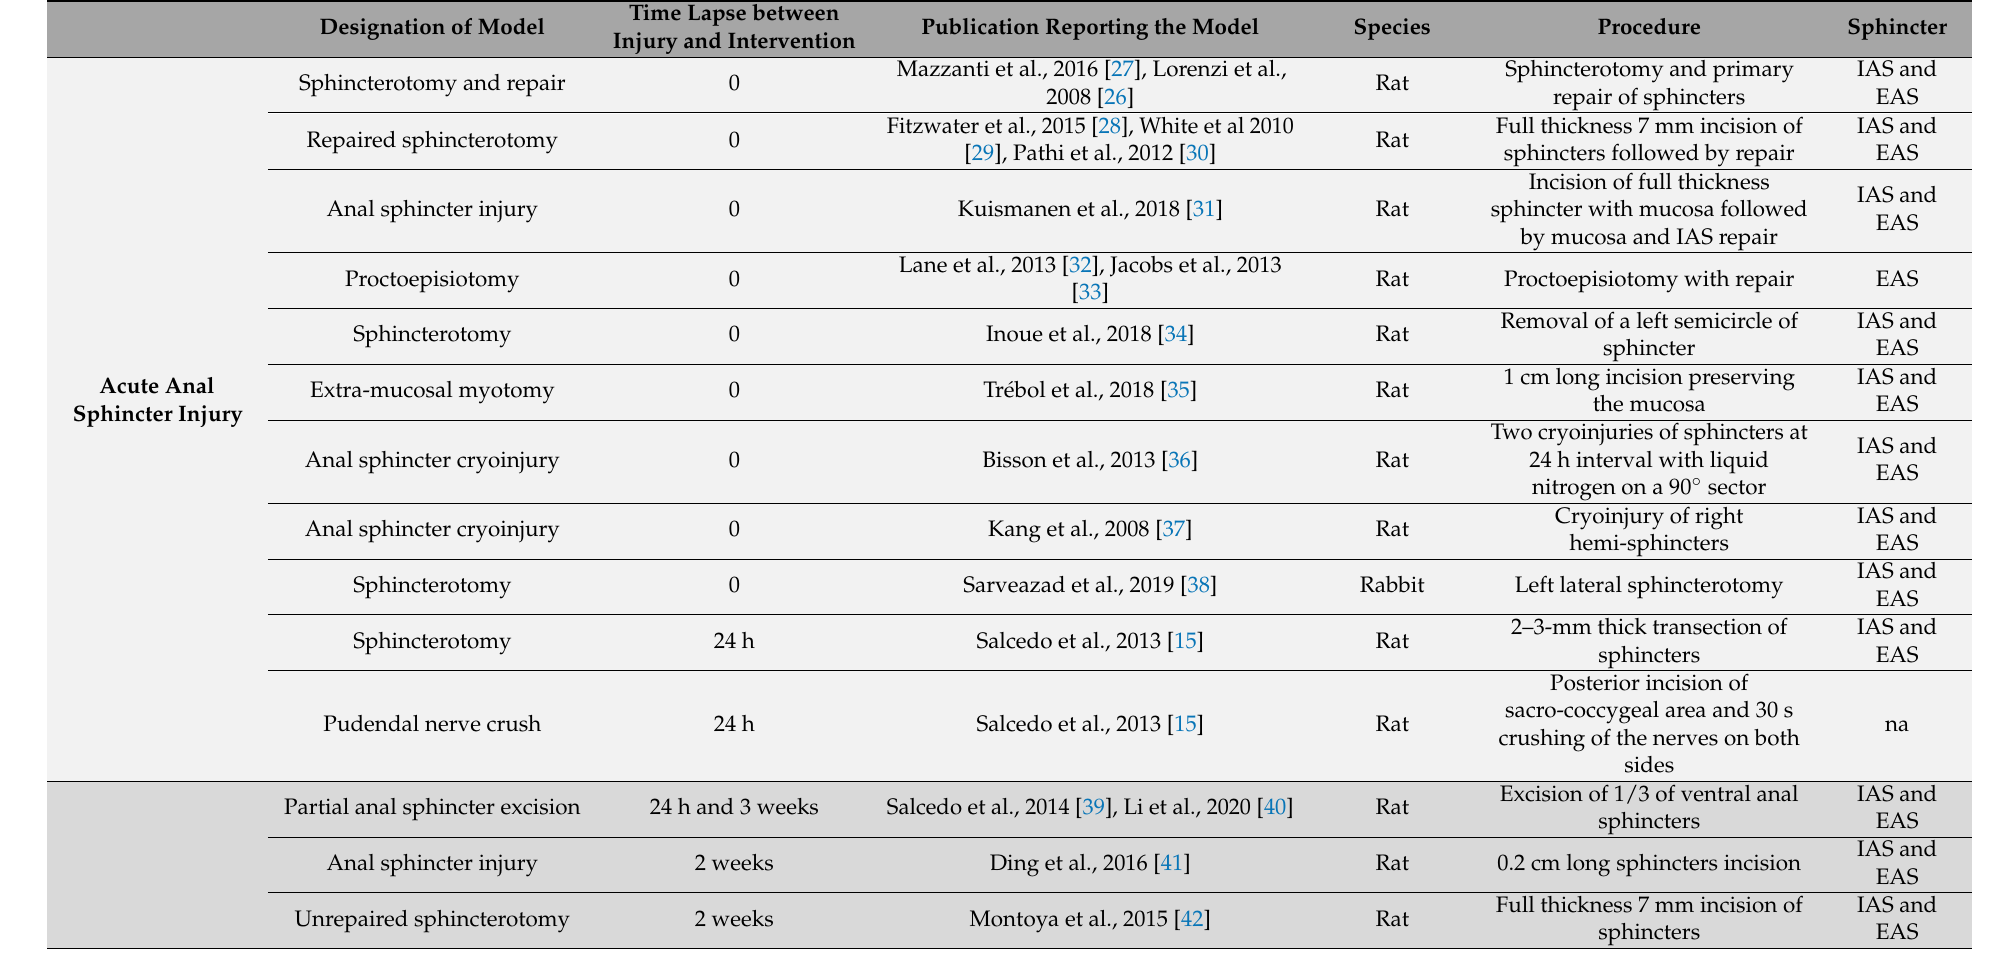
Table 1. Models for anal sphincter incontinence. NHP: Non-human